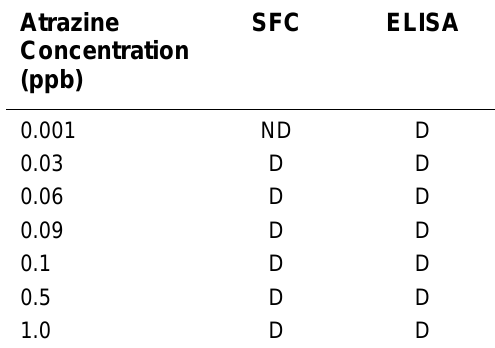
MDL of Atrazine by SFC/UVD at 220 nm and ELISA Technique at 450 nm Atrazine Concentration (ppb)